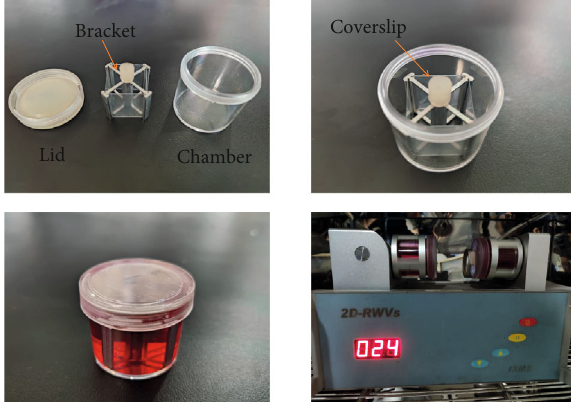
Figure 1: The structure of 2D-clinostat and simulated microgravity